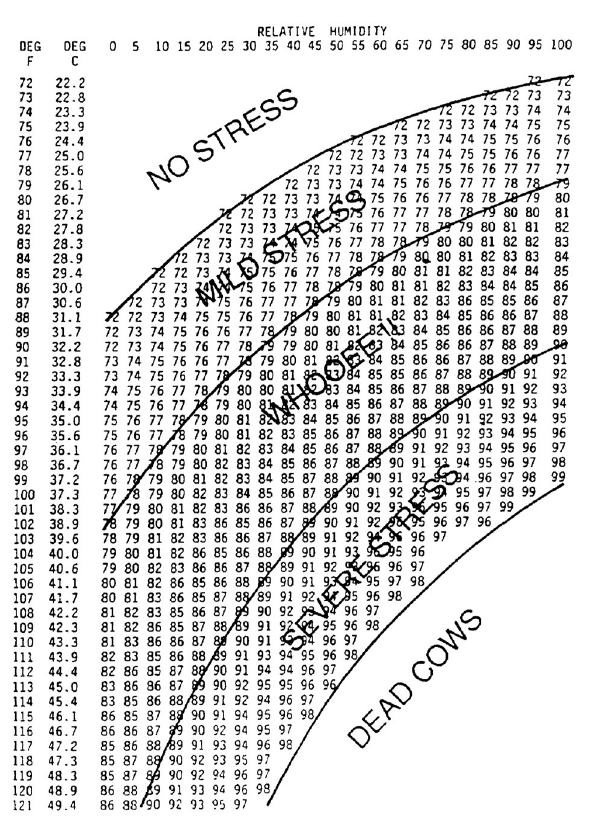
FIGURE2 Temperature-humidity index (THI) table for dairy producer to estimate heat stress for dairy cows. Deg, Degrees. Relative humidity expressed as percentage. Adapted from Armstrong (23).